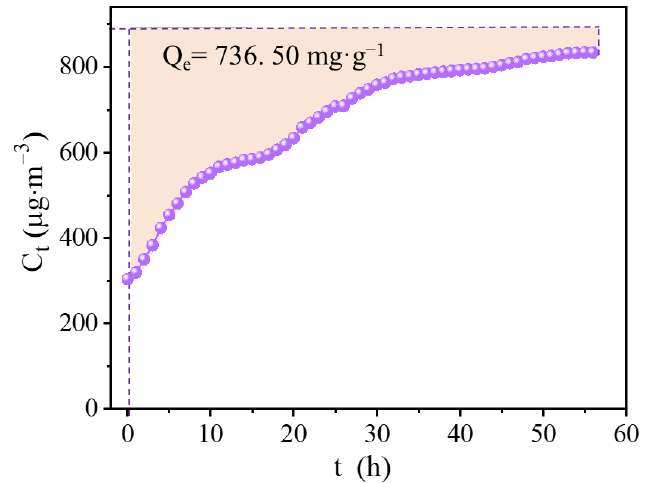
Figure 7. The adsorption breakthrough curve of c-CuS under 6% vol SO 2 + 6% vol O 2 (Experimental condition: solution volume = 10 mL, solution pH = 3.0, solution temperature = 20 °C, flue gas was 6% vol SO 2 + 6% vol O 2 + N 2 , the inlet concentration of Hg 0 was 890 µg·m −3 ). Figure 8. Comparison of adsorption capacity and rate with reported metal sulfide materials.